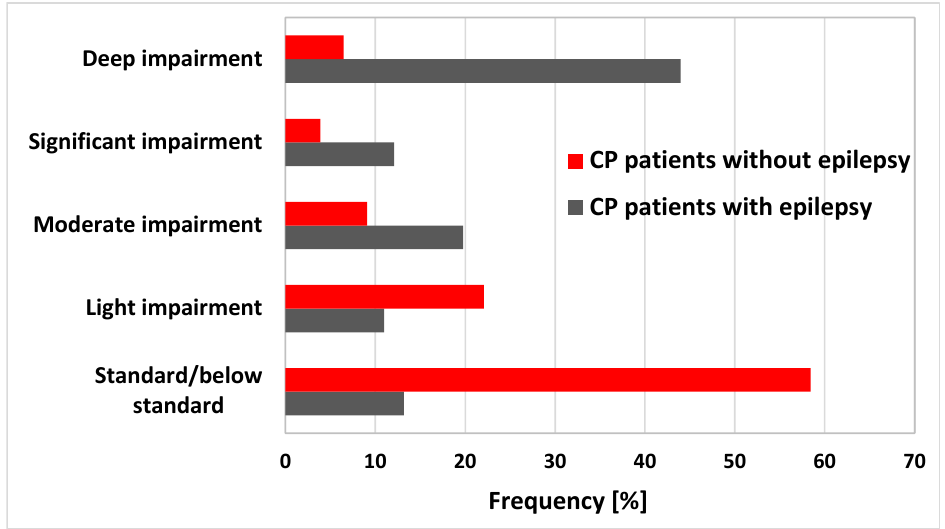
Figure 3. The distribution of intellectual disabilities in CP patients with and without epilepsy. CP—cerebral palsy.